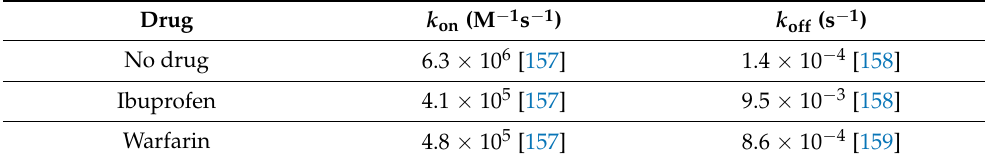
Table 3. Rate constants for nitrosylation ( k on ) and denitrosylation ( k off ) of ferrous heme–HSA.